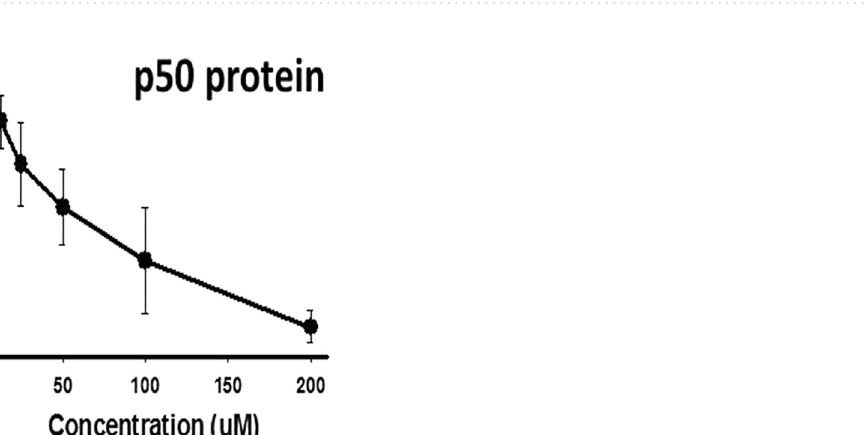
Figure 4. (A) NF-κB as a target for antitumor action of mammary carcinogenesis by DHA and metabolites (4-OXO-DHA). (B) Presentation of our working hypothesis.